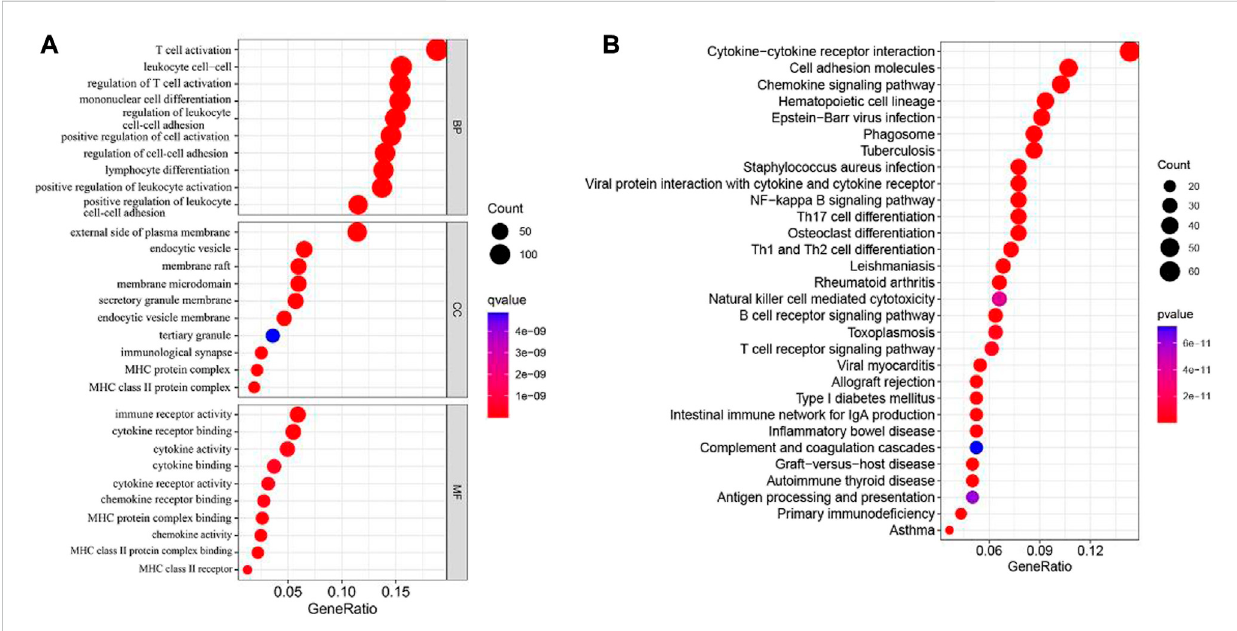
FIGURE 4 GO and KEGG analyses for cuproptosis-related differential genes in melanoma. (A) GO analysis. (B) KEGG